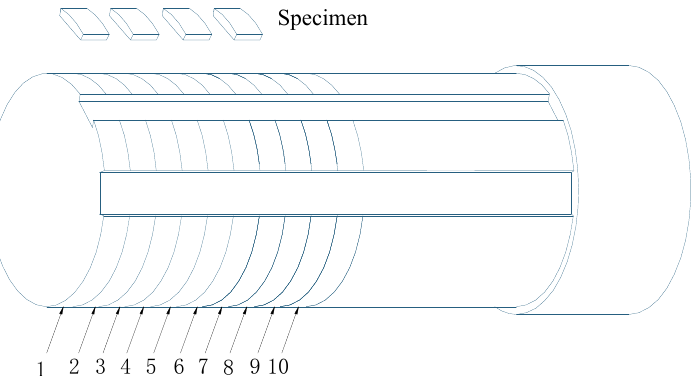
Figure 1. A schematic diagram of the surface layer sample.